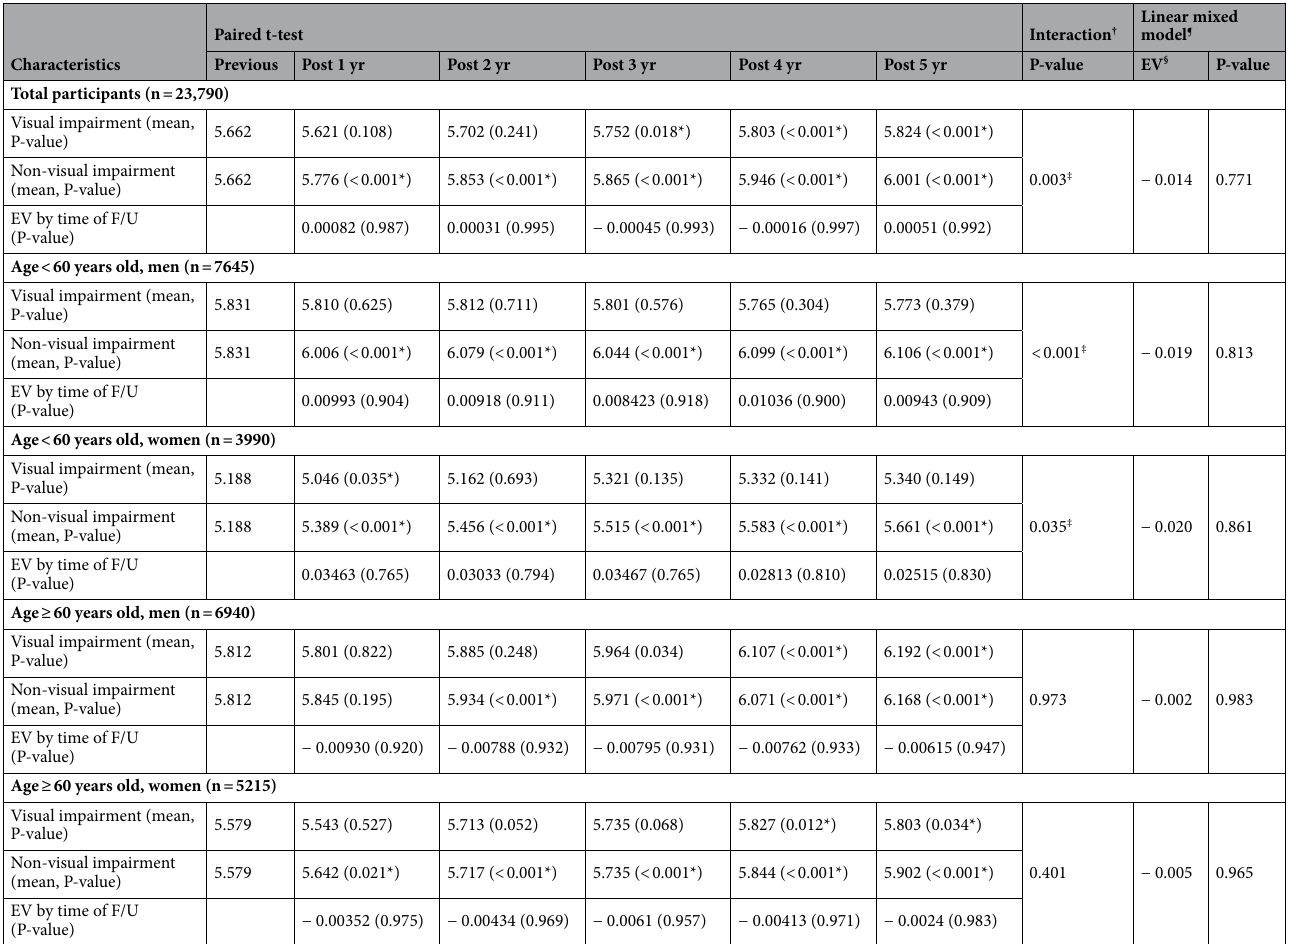
Table 2. Distribution/repartition of mean of income value over time in visual impairment and non-visual impairment groups. EV, Estimated value; CCI, Charlson Comorbidity Index. *Paired t-test based on previous income, significance at P < 0.05. † Interaction effects between time and group. ‡ Interaction effects by linear mixed model, significance at P < 0.05. § Estimated value of linear mixed model for visual impairment group based on control group. ¶ Fixed effects were age, sex, region of residence, visual impairment, and time of measurement. Random effects were BMI, systolic blood pressure, diastolic blood pressure, fasting blood glucose, total cholesterol, smoking, alcohol consumption, and CCI